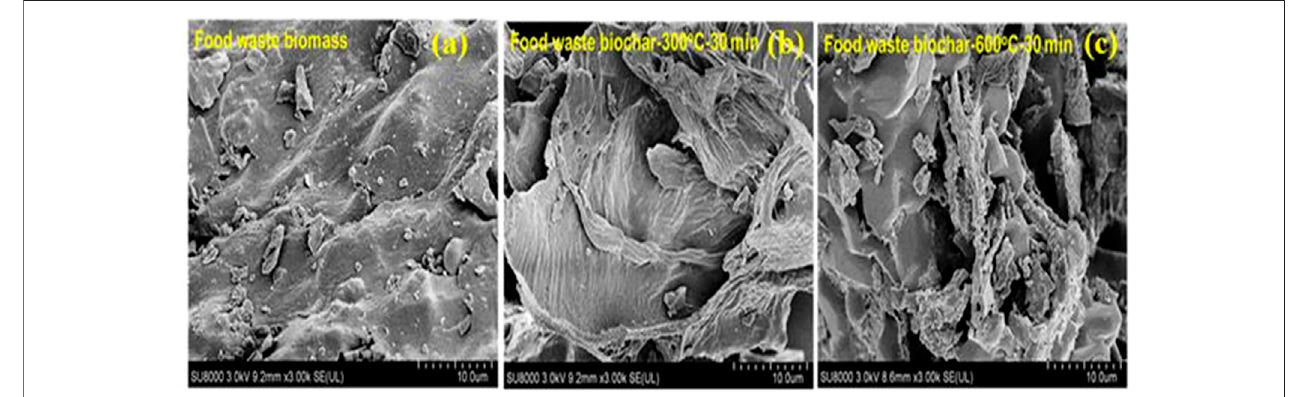
FIGURE 9 | (A-C). SEM image of food waste biochar derived from different pyrolysis temperature (used with permission from Patra et al.,